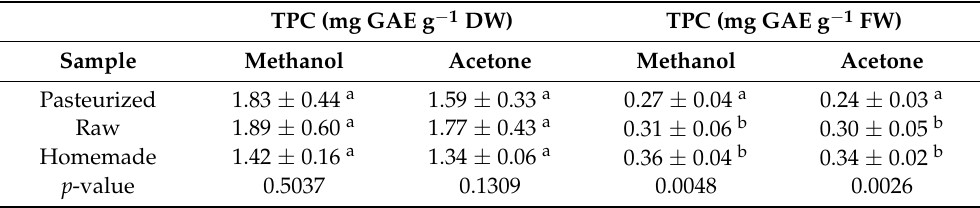
Table 4. Average content of total polyphenols (mg gallic acid equivalent (GAE) per g freeze dried sample or per g fresh weight) of salmorejo samples (mean ±